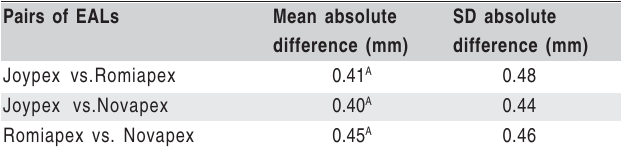
Table 1. Mean and standard deviation (SD) values of absolute differences among the three electronic apex locators (EALs) compared in pairs.